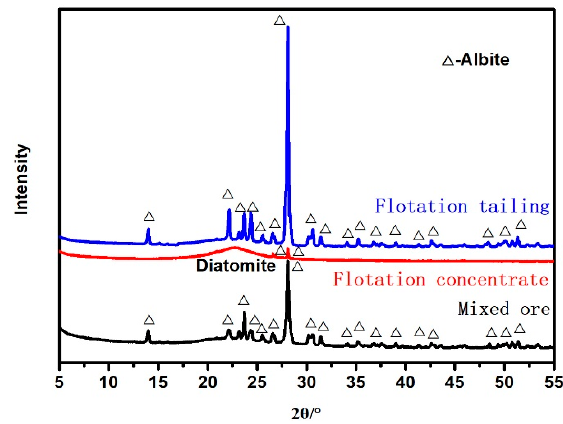
Figure 3. XRD patterns of the mixed ore, flotation concentrate, and tailings.